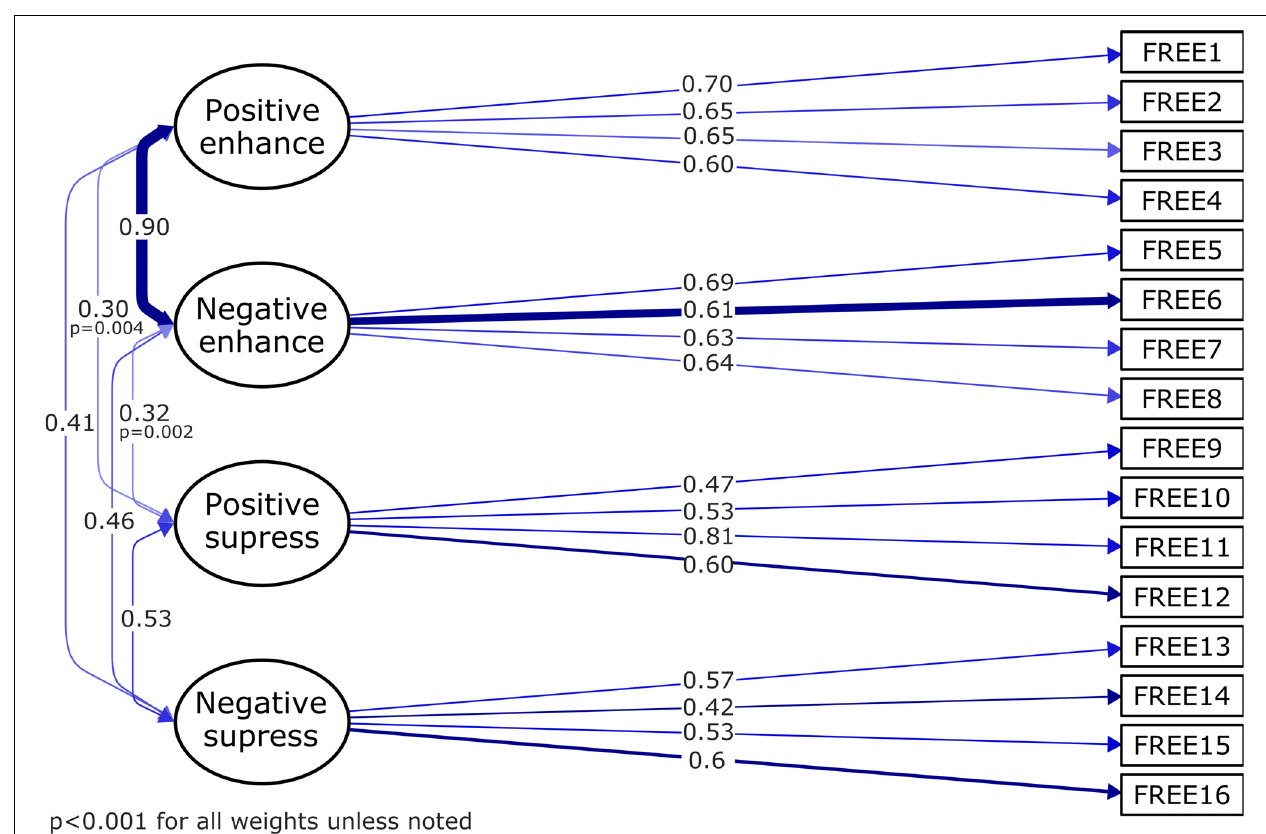
FIGURE 2 | Path diagram of the confirmatory factor analysis (CFA) “correlated factor” model. This figure shows the standardized factor loadings for the “correlated factor” model of the FREE scale. The rectangles indicate the 16 items of the scale; the four directly connected ellipses represent the latent variables (subscales). The lines represent the causal effects from the first-order factors to the individual items. The line thickness/continuity indicates the magnitude of the loading